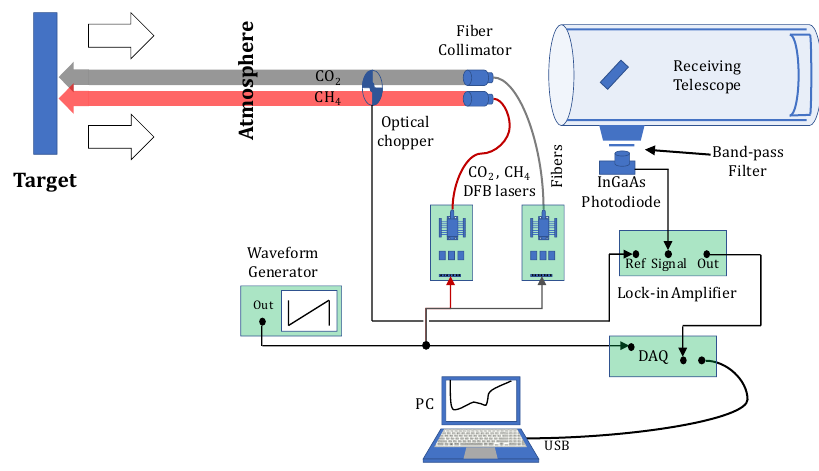
Figure 1. Diagram of the instrument’s setup.